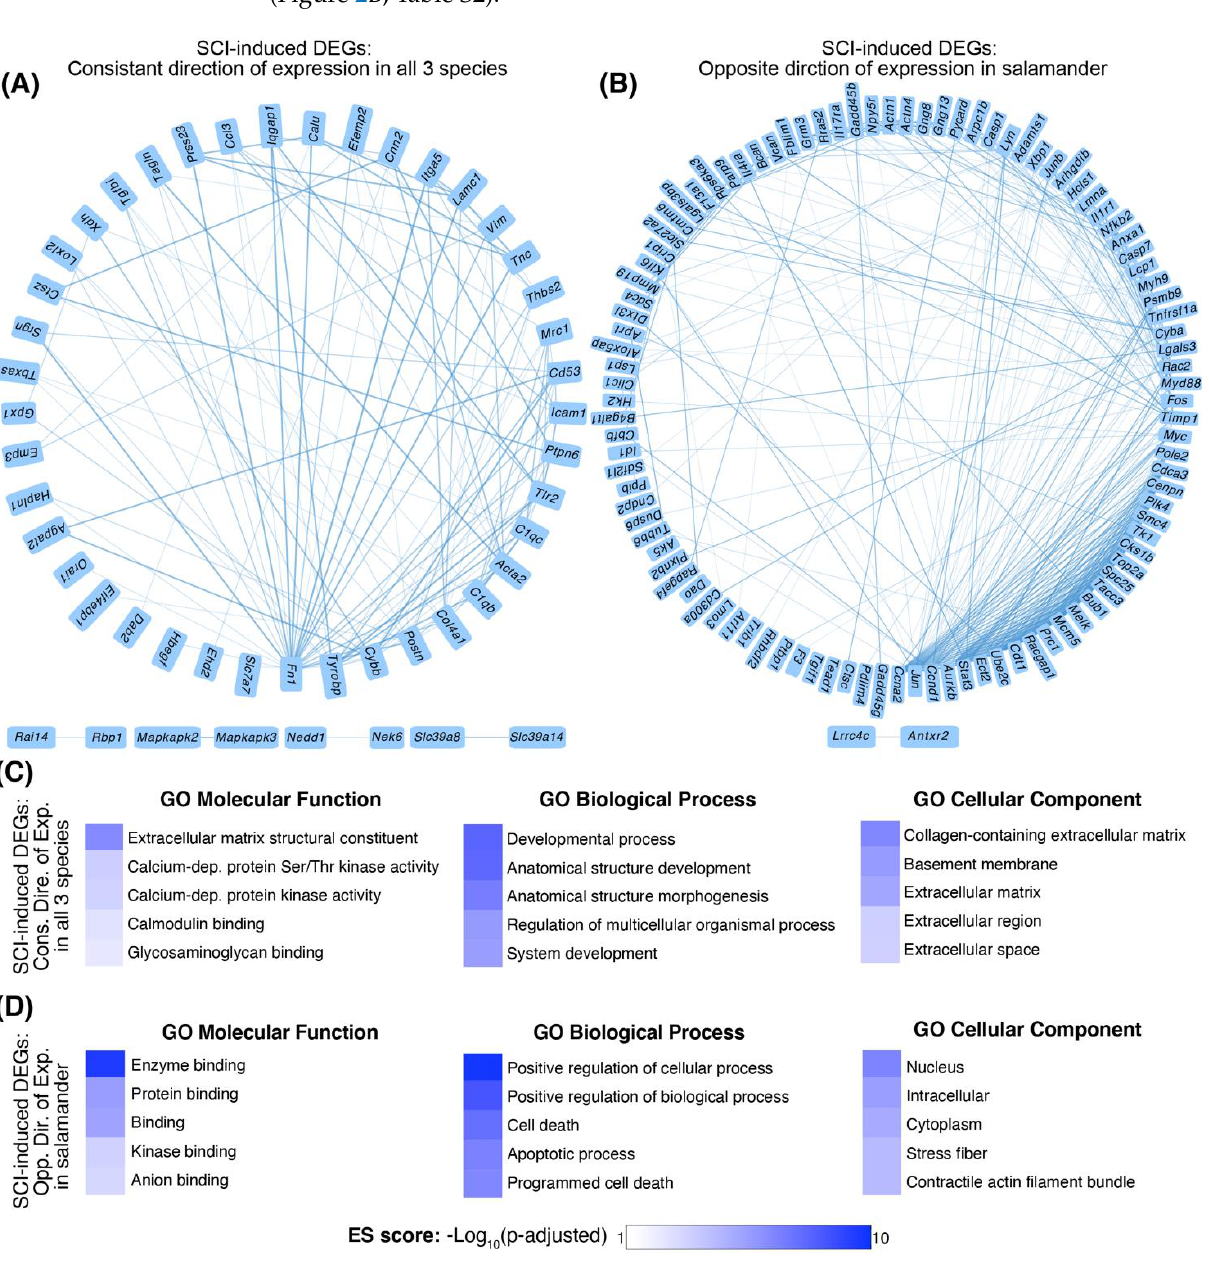
three species, the most enriched GO-MF and GO-CC terms were related to the extracellu- lar matrix (ECM), such as “extracellular matrix structural constituent” ( p -adj. = 1.10 × 10 −6 ,